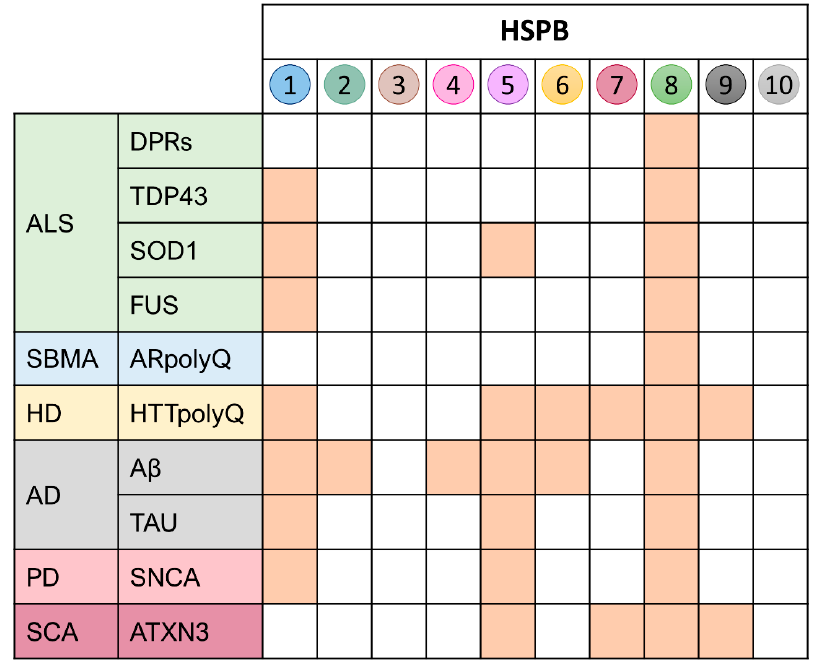
Figure 3. HSPBs anti-aggregating and/or pro-degradative functions against MND/ND substrates. This graph outlines the substrates against which HSPBs have been found to exert their activity (orange squares).